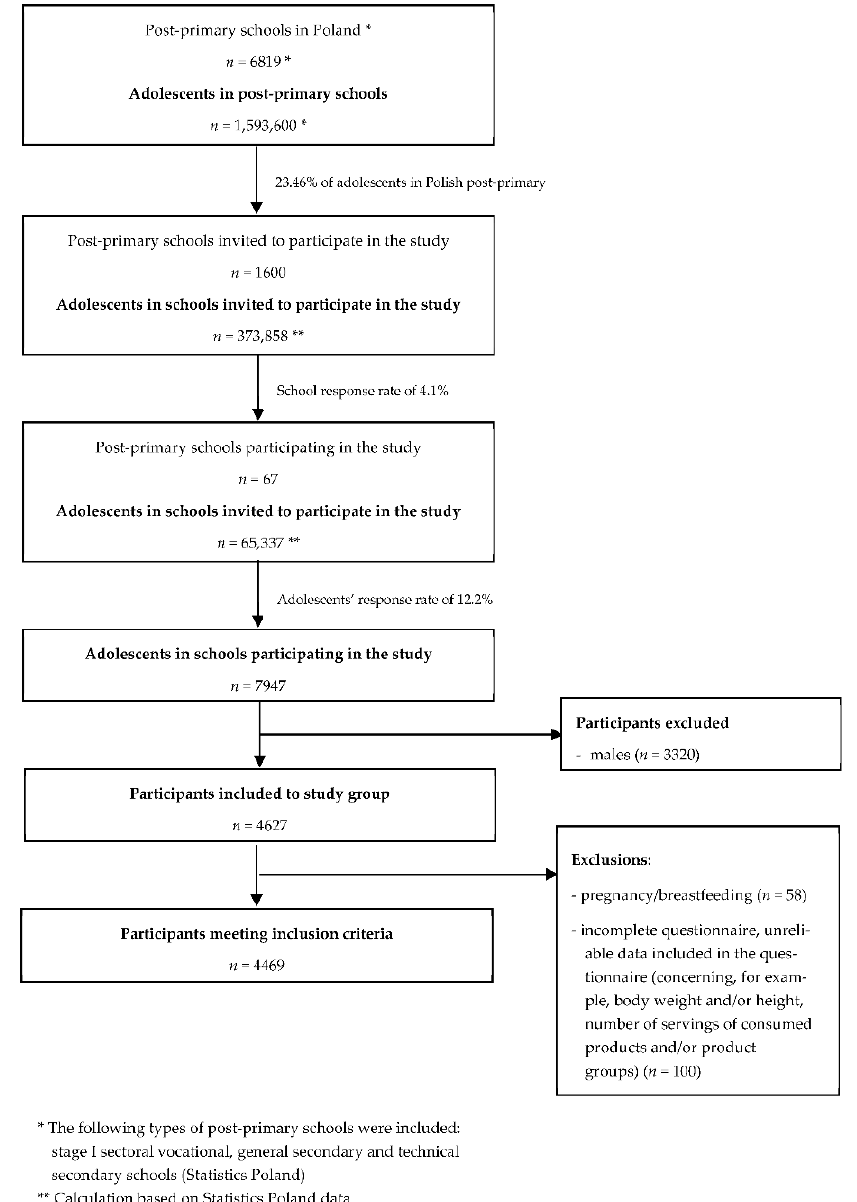
Figure 1. The sampling and recruitment procedure for the study group.